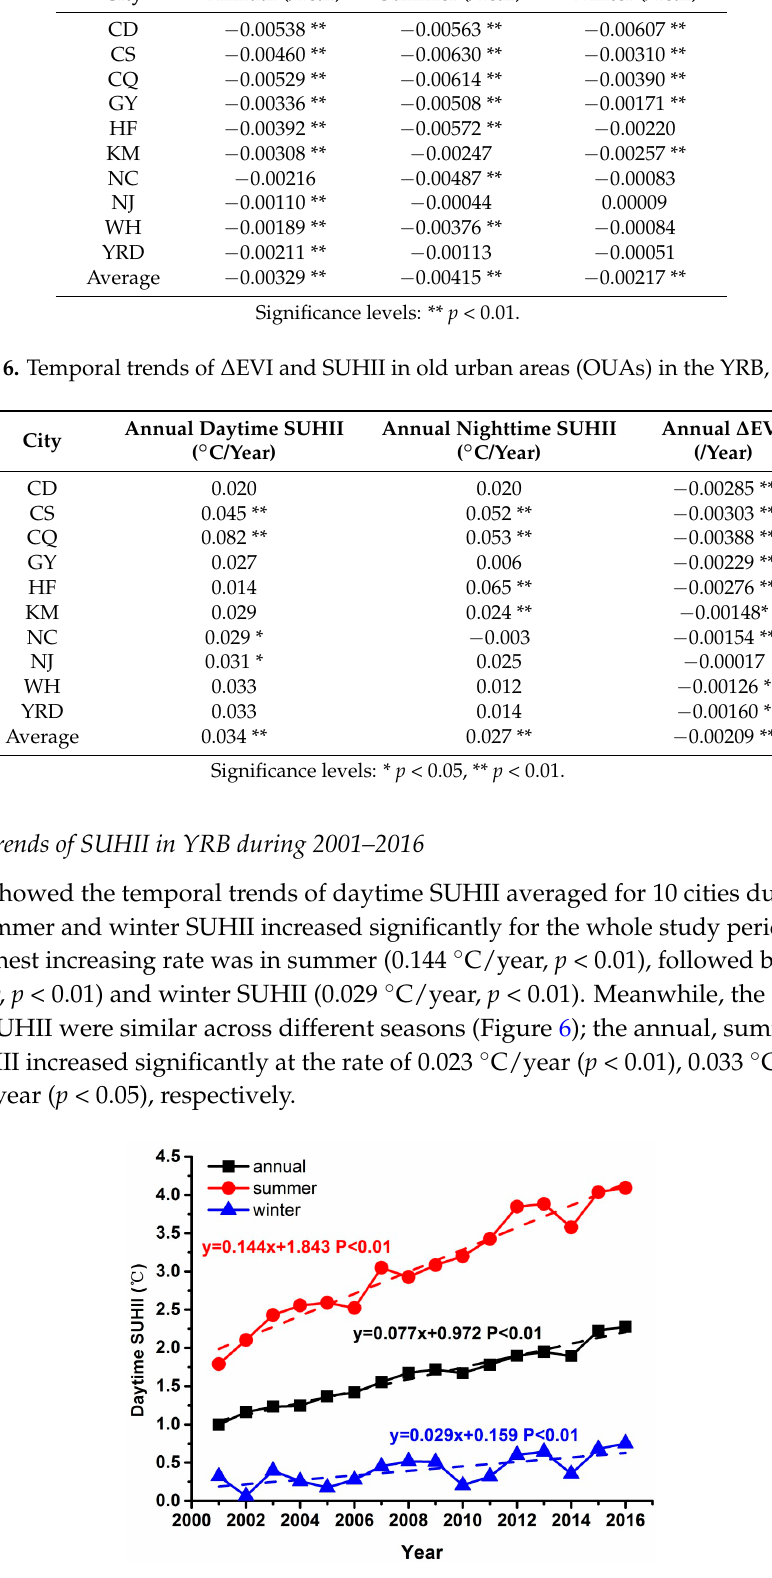
Figure 5. The temporal trends of daytime SUHII averaged for 10 cities during 2001–2016.